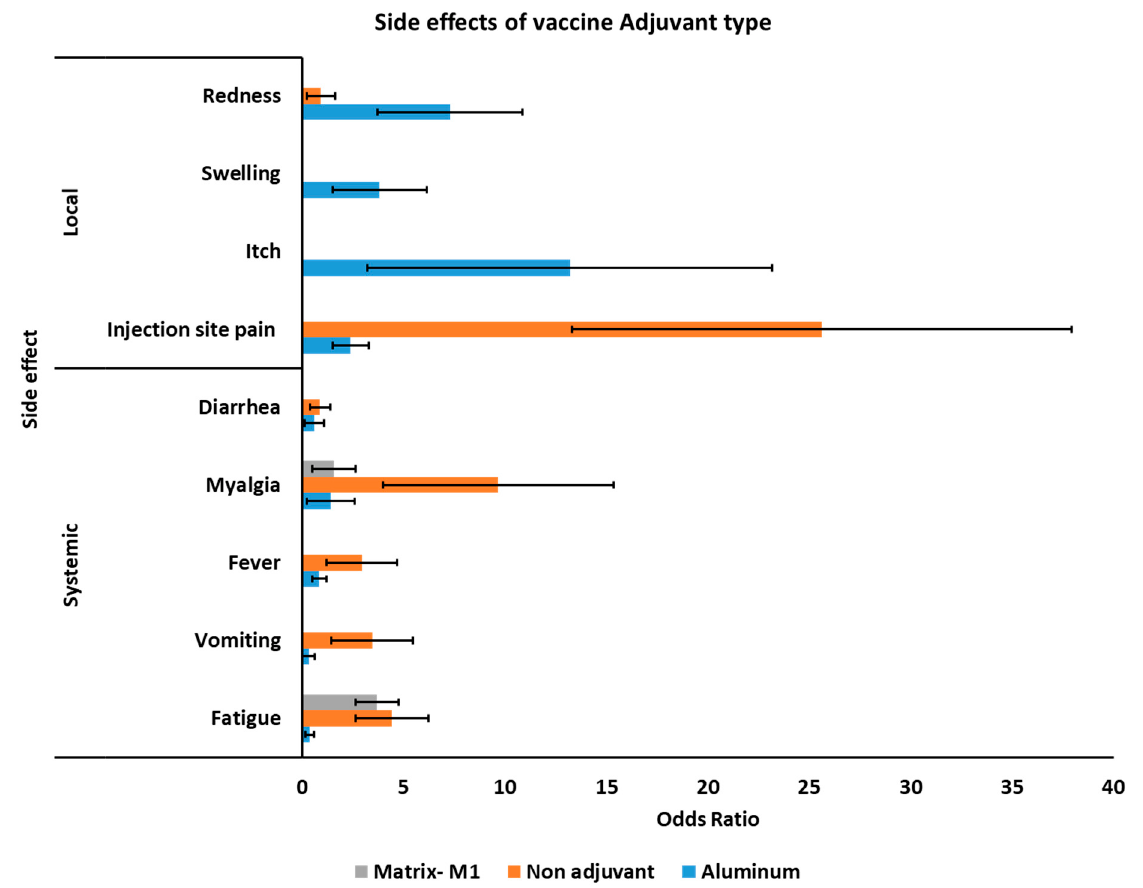
Figure 4. Association of adjuvant side effects of different COVID-19 vaccines.